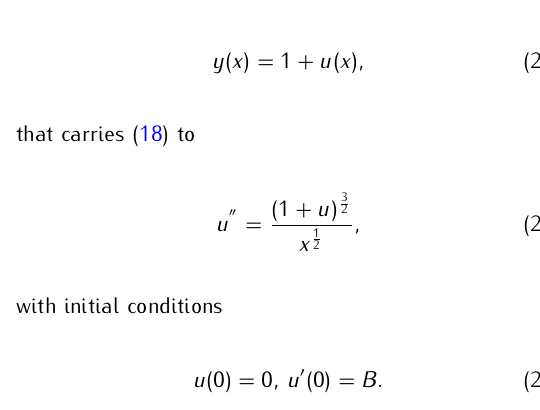
Figure 2. Padé approximant